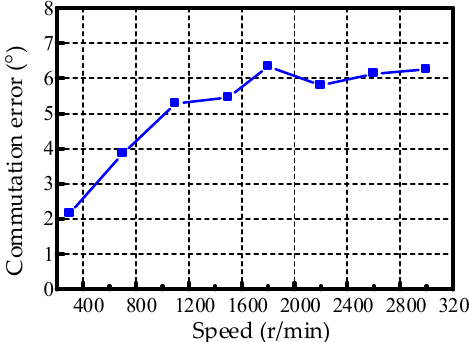
Figure 27. Commutation errors at different speeds.